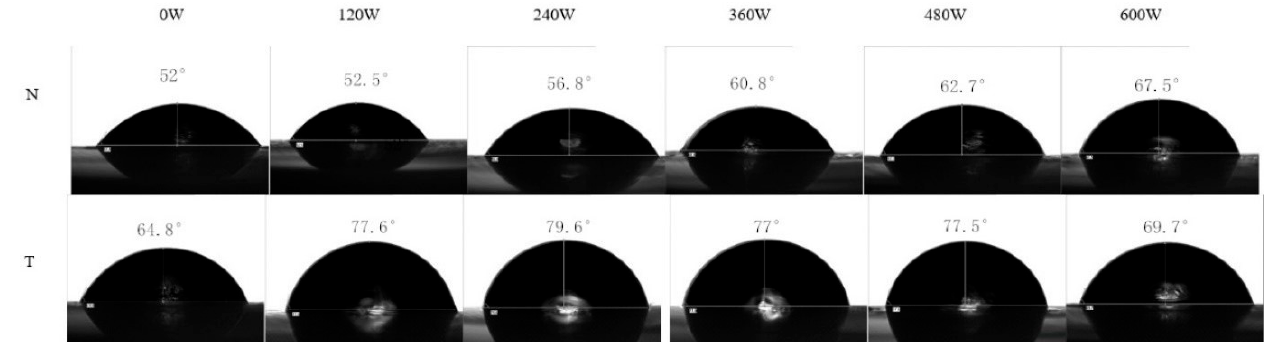
Figure 2. The effect of different treatments on the three-phase contact angle. (The EWP-GPs were treated with ultrasound from 0 W to 600 W, respectively. The “N” represents EWP-GPs without TGase treatment, and the “T” represents EWP-GPs with TGase treatment.)